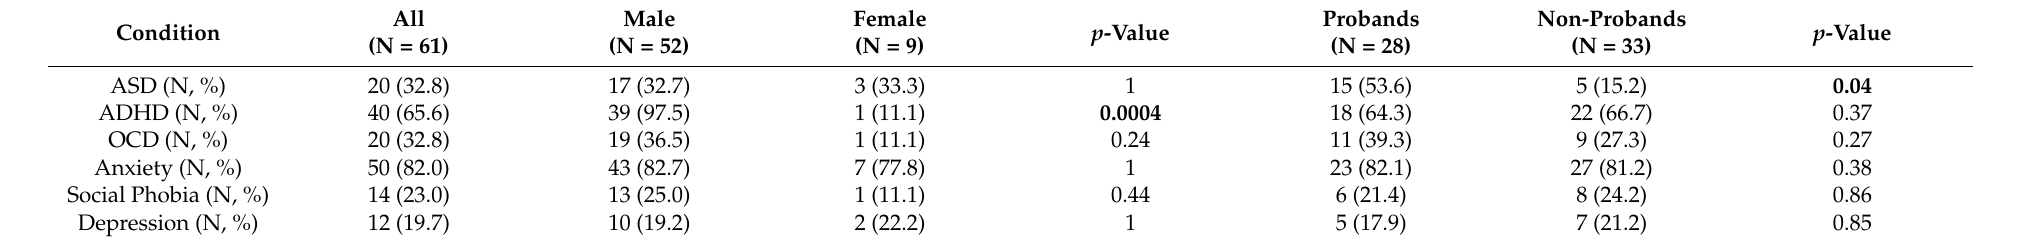
Table 2. FXAND-related conditions in the samples of young PM